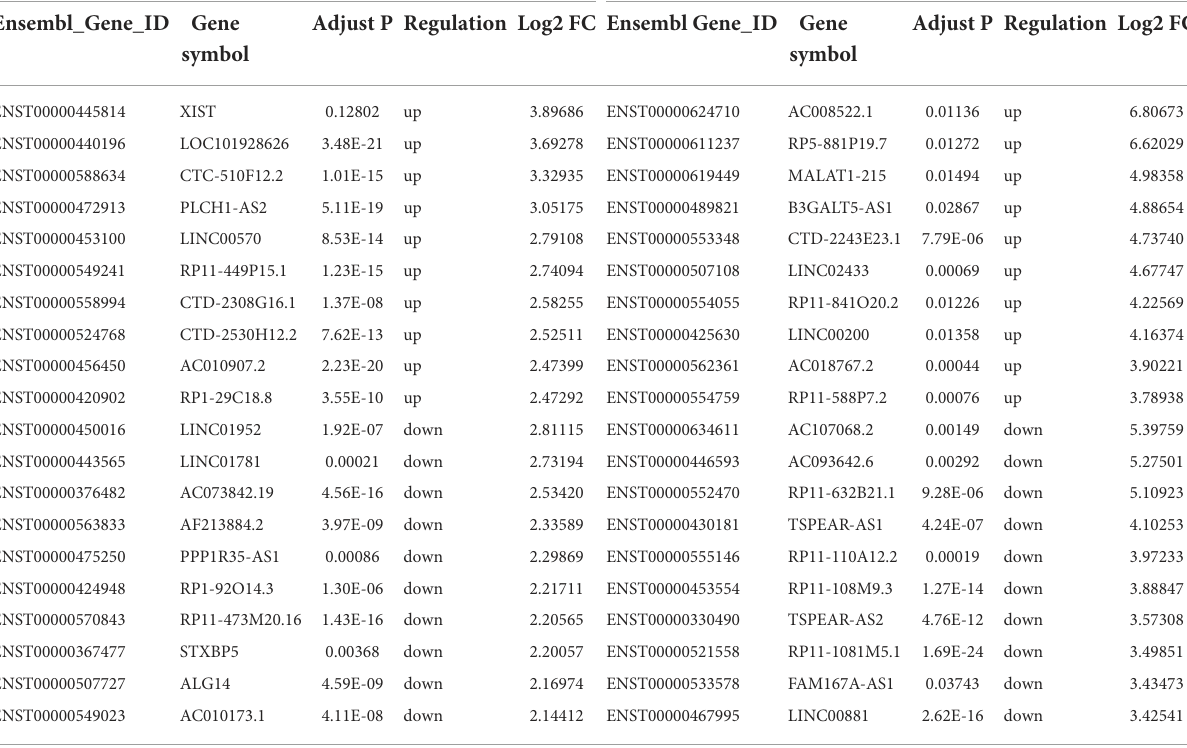
TABLE 1 Top 10 upregulated and downregulated long noncoding RNAs in the myocardial tissues of patients with HCM in GSE68316 and